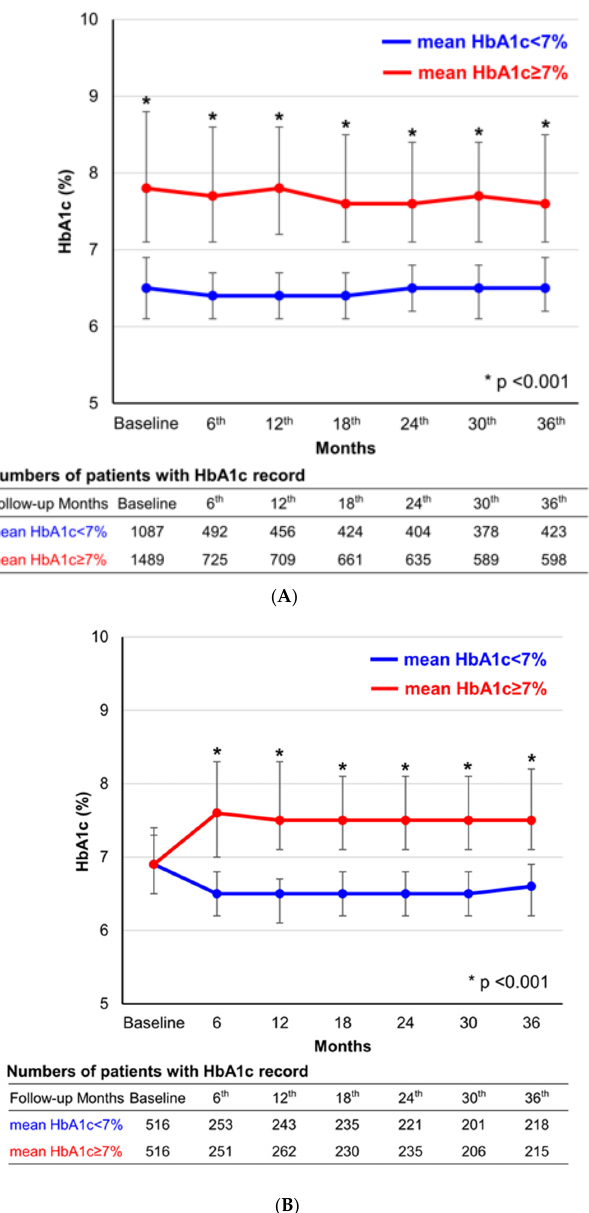
Figure 2. Temporal changes in HbA1c in the overall and propensity score matched 516 paired populations. The figures represent the temporal changes in HbA1c among the overall ( A ) and propensity score matched population ( B ). The blue and red lines represent the mean HbA1c < 7.0 group and mean HbA1c ≥ 7.0 group, respectively. The error bars represent the interquartile range of HbA1c level.